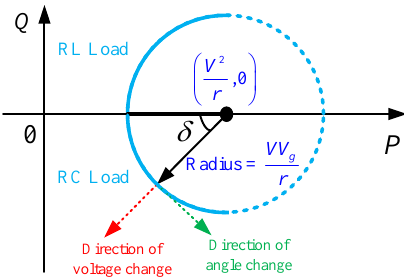
Figure 2. Power circle diagram of Equations (3) and (4). RL: resistance-inductance; and RC: resistance-capacitance.